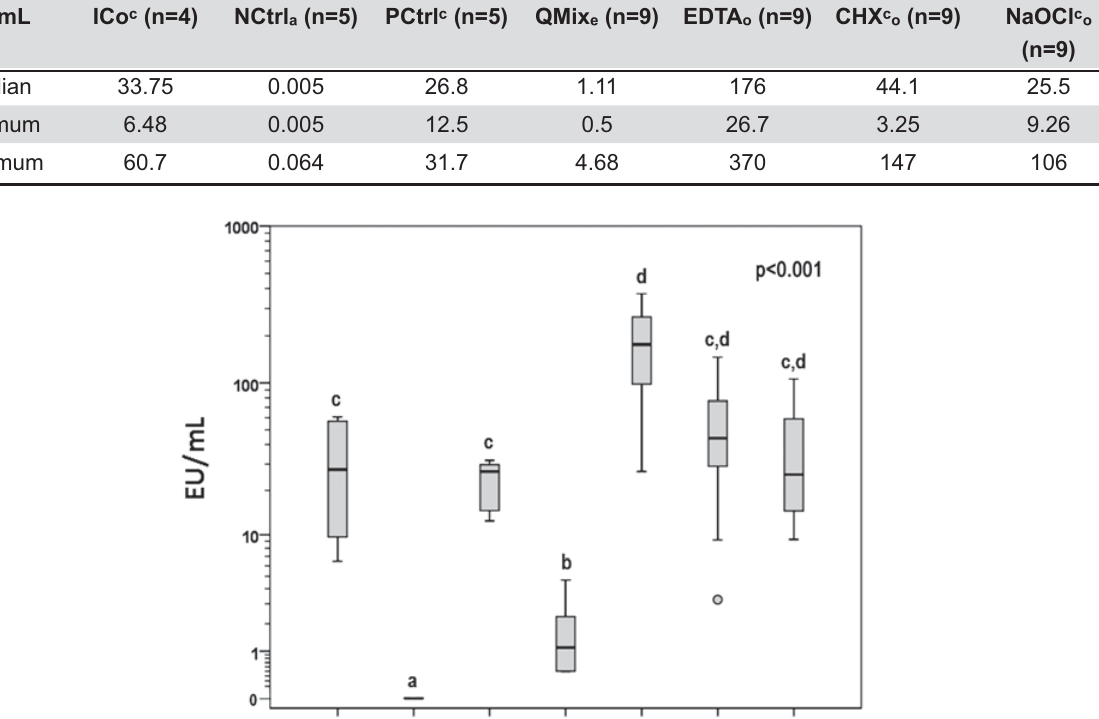
Table 1 and Figure 1 show the endotoxin load for both control and test groups. QMix ® reached the